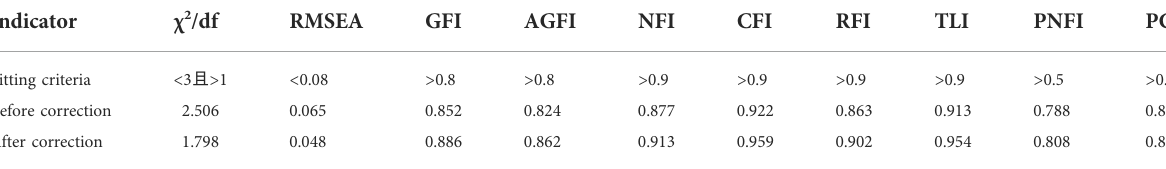
TABLE 3 Comparison of simulation fi tting results.